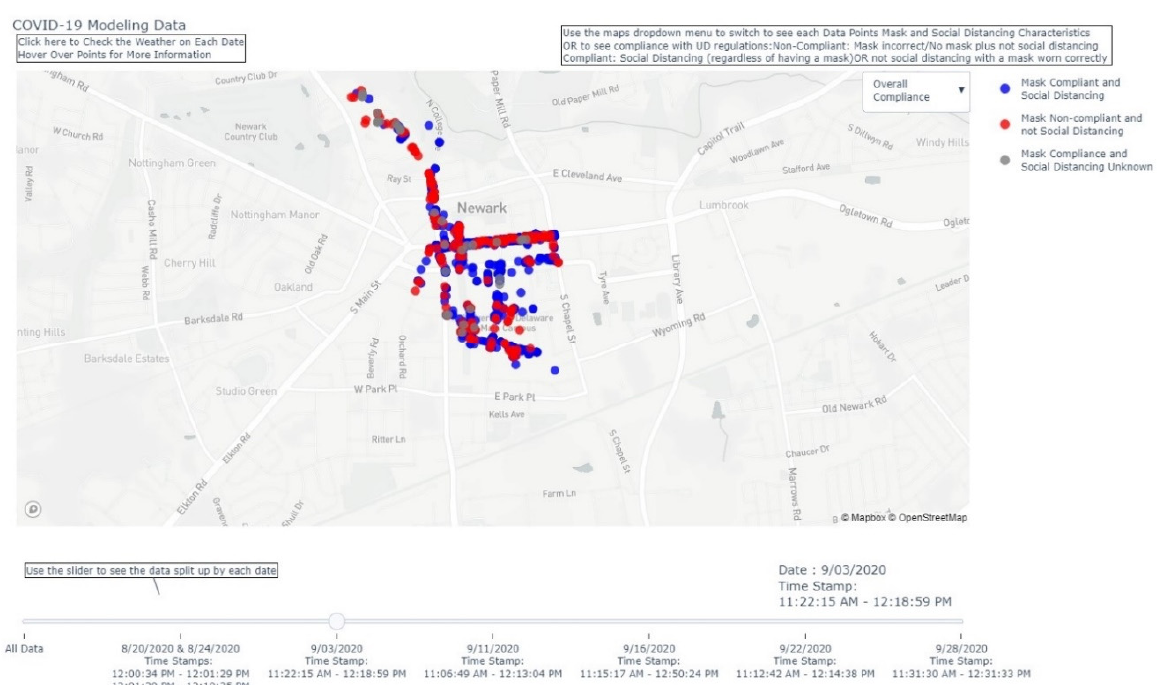
Figure 8. Spatial distribution of mask and physical distancing non-compliance.